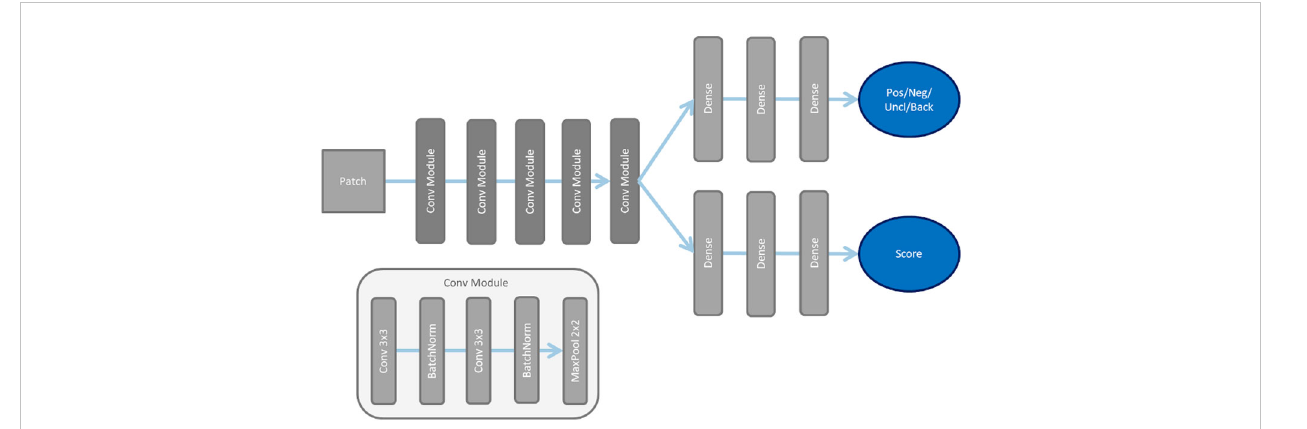
FIGURE 3 For processing the samples of the subregions of the salt-split skin substrate, the displayed deep network architecture is used. After processing by convolution module shown below, the processing is divided into two branches of dense layers for the different